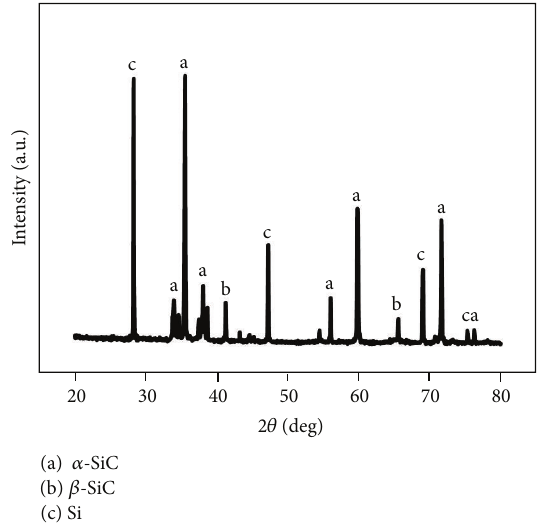
Table 1: Parameters of the magnetron sputtering process. Distance between the sample and target (mm) 60 500 3 5